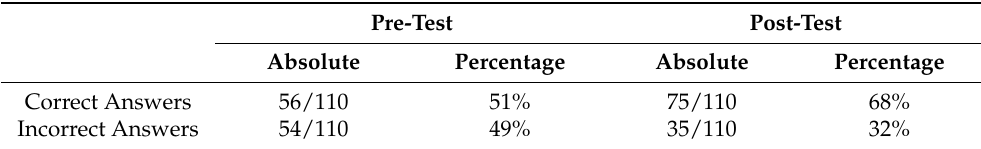
Table 1. Comparison of pre-test and post-test results. A total of 110 comprehension items—10 items per person—was answered by 11 students before and after their lesson to track comprehension. Correct answers increased from 51% to